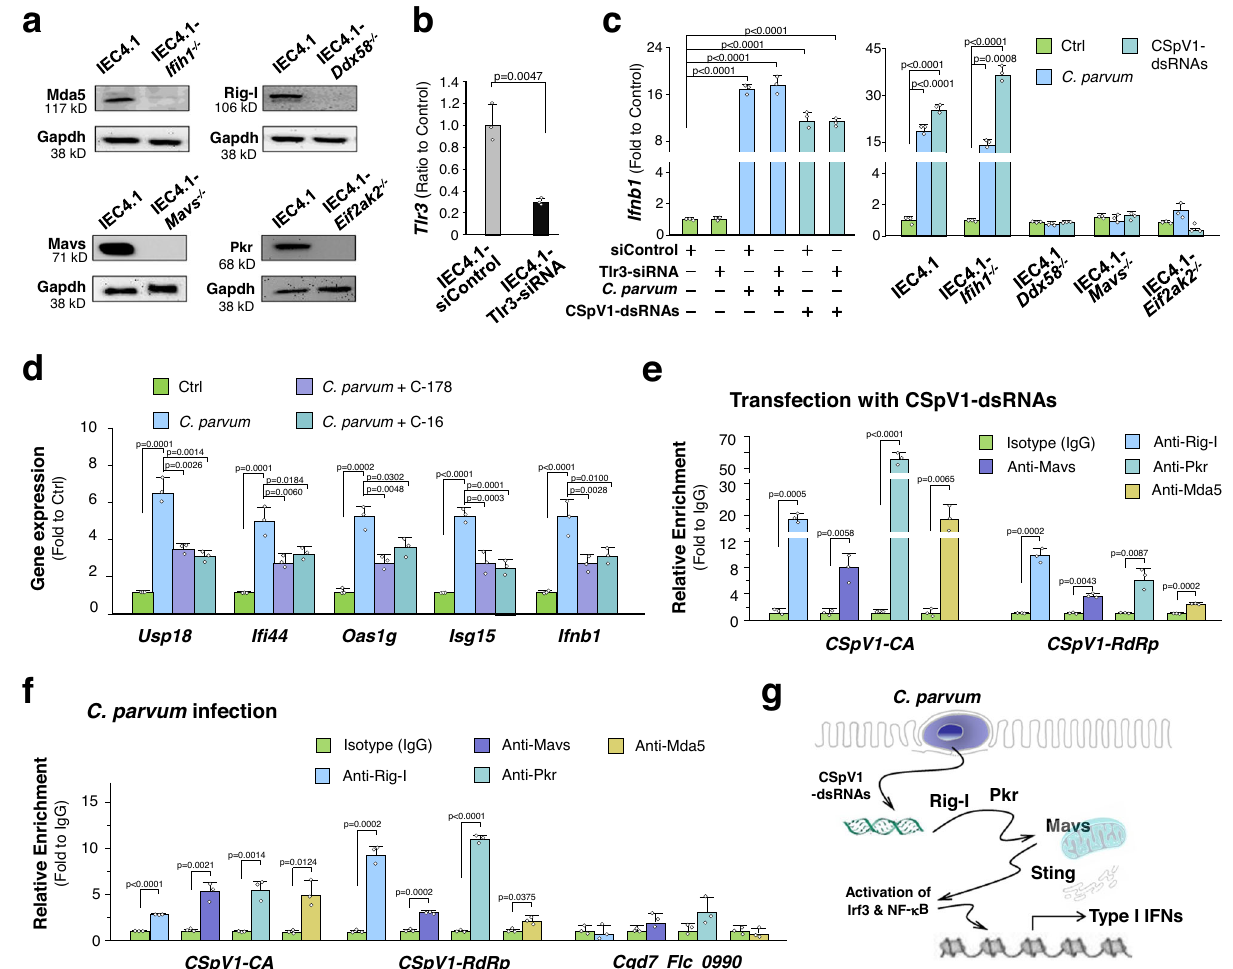
Fig.5|CSpV1-dsRNAstriggertypeIIFNsignalingthroughactivationofthePkr and Rig-I/Mavs/Sting signaling pathways. a Stable IEC4.1 cells de fi cient in I fi h1 ,